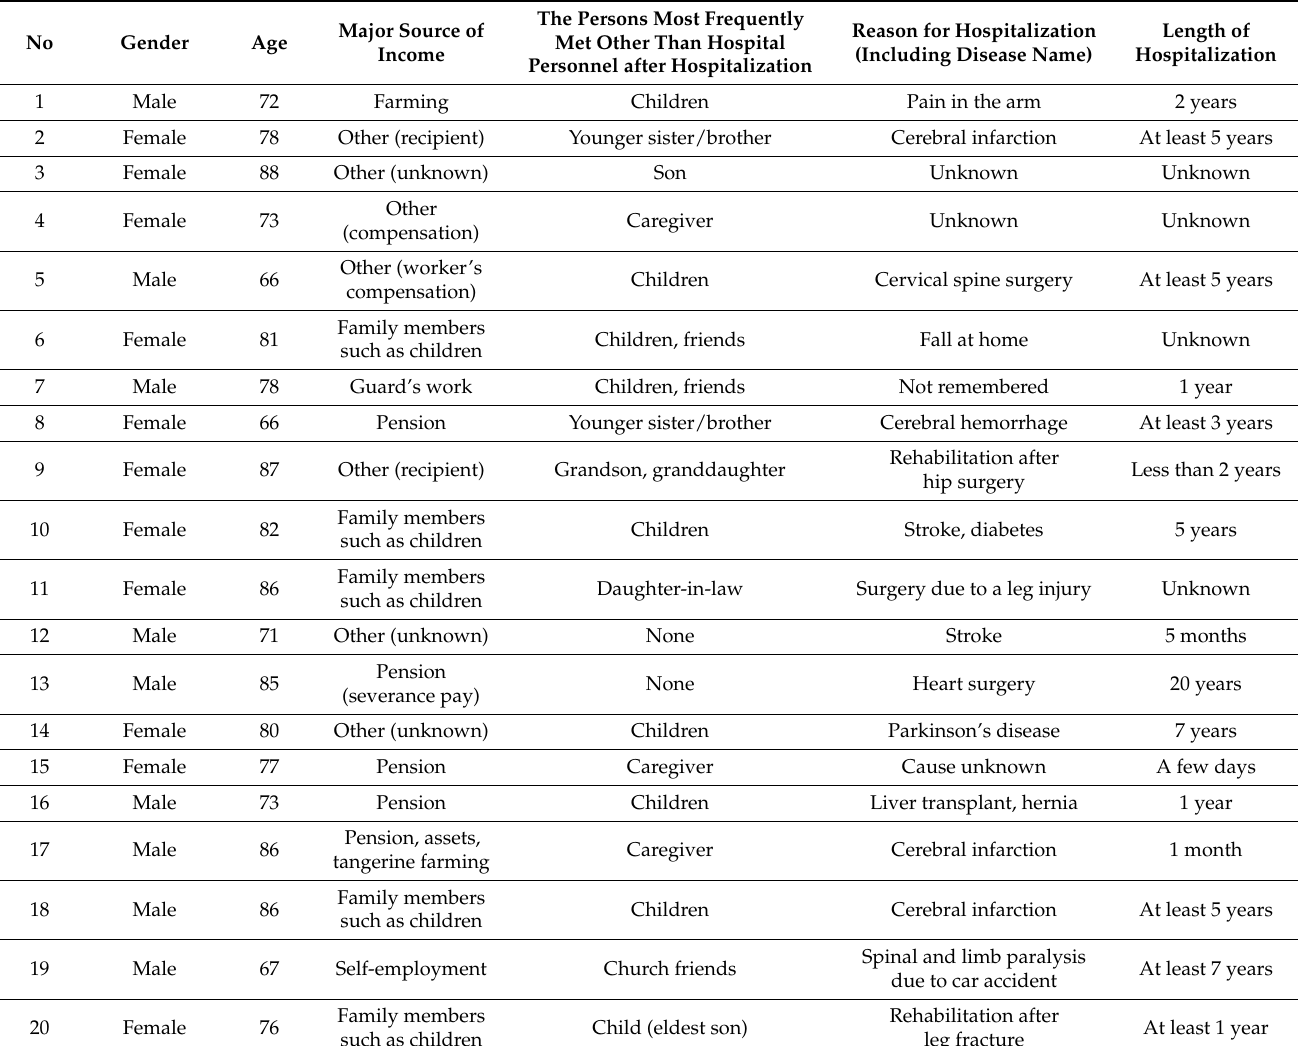
Table 1. Demographic background of senior